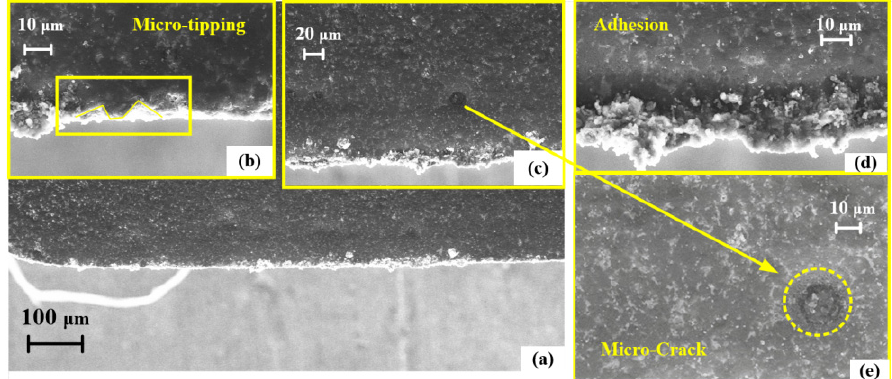
Figure 6. The SEM image of ( a ) non-textured tool surface after orthogonal cutting; ( b )micro-tip- ping; ( c ) micro-crack; ( d ) adhesion; ( e ) micro-crack. ( c ) micro-crack; ( d ) adhesion; ( e )